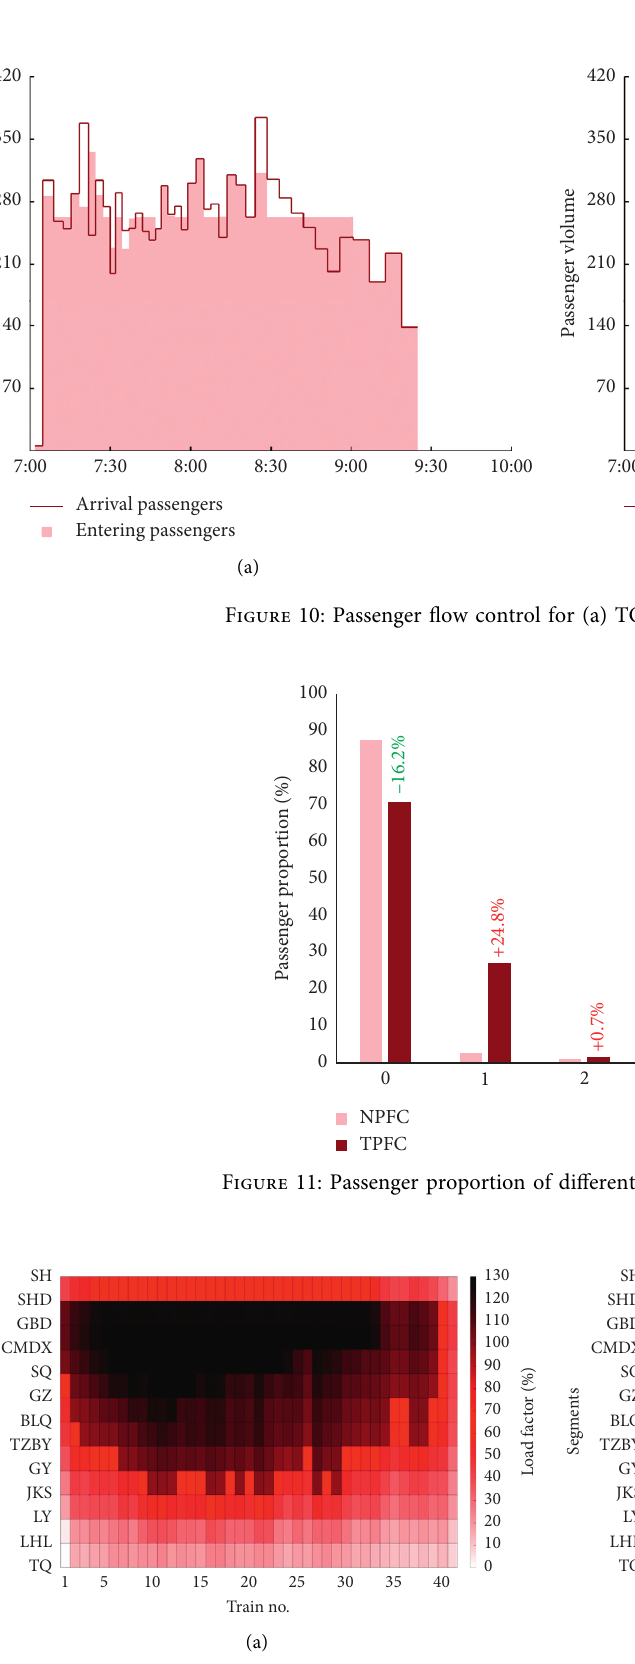
Figure 12: Comparison on train load factor: (a) NPFC; (b) TPFC.